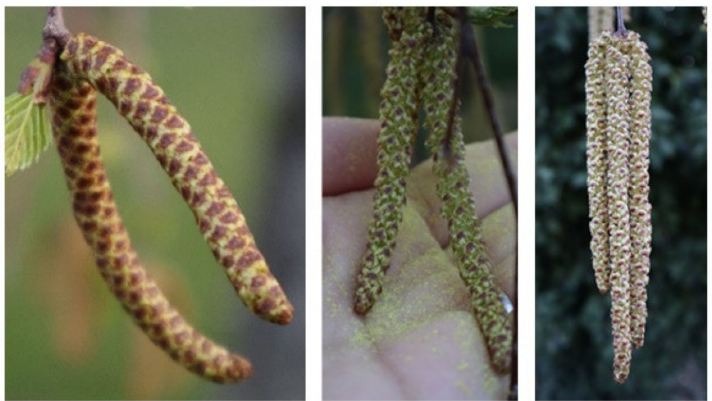
Figure 2. Flowering phenophases of Betula pendula . Left: closed inflorescences, middle: open inflorescence with prominent stamens (start of flowering), right: desiccated inflorescence without stamens (end of